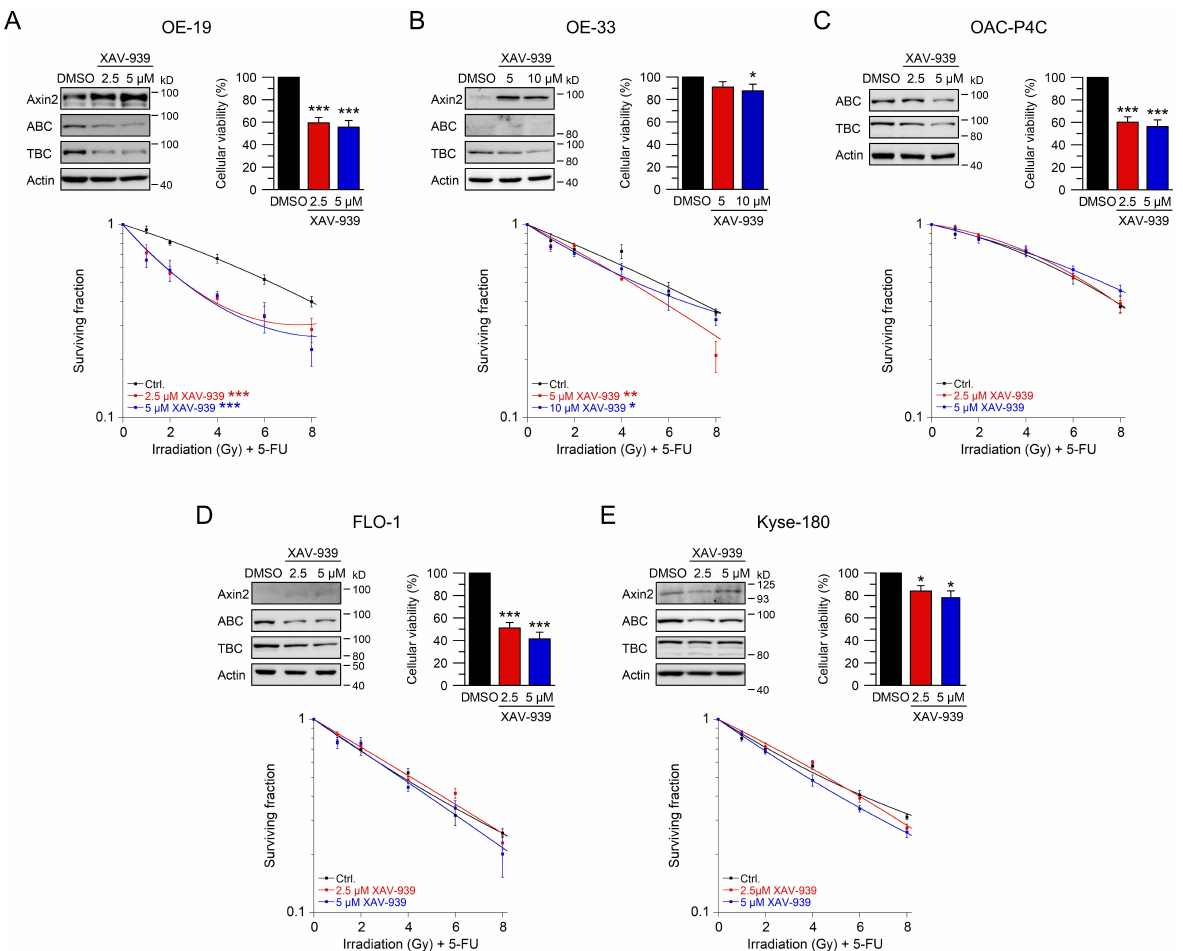
Figure 4. Inhibition of Wnt/ β -catenin signaling by the tankyrase inhibitor XAV-939. ( A – E ) Cell lines were left untreated (DMSO), or treated with two different concentrations of the tankyrase inhibitor XAV-939. Cell lines (( A )—OE-19, ( B )—OE-33, ( C )—OAC-P4C, ( D )—FLO-1, ( E )—Kyse-180) were first subjected to Western blot analysis (upper left), or cellular viability assays (upper right), or were monitored for CFA survival after CRT (lower graphs). Data presented as mean ± s.e.m. from at least n = 3 independent biological replicates. * p < 0.05, ** p < 0.01, *** p < 0.001, two-way analysis of variance (ANOVA). For p -values see Table